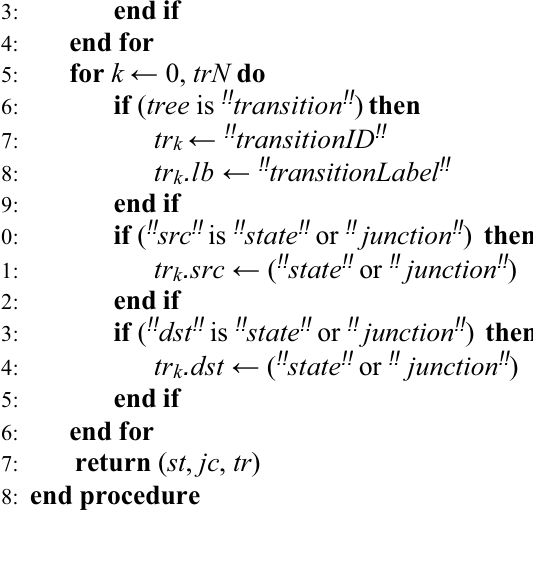
Fig. 3. XML to intermediate file